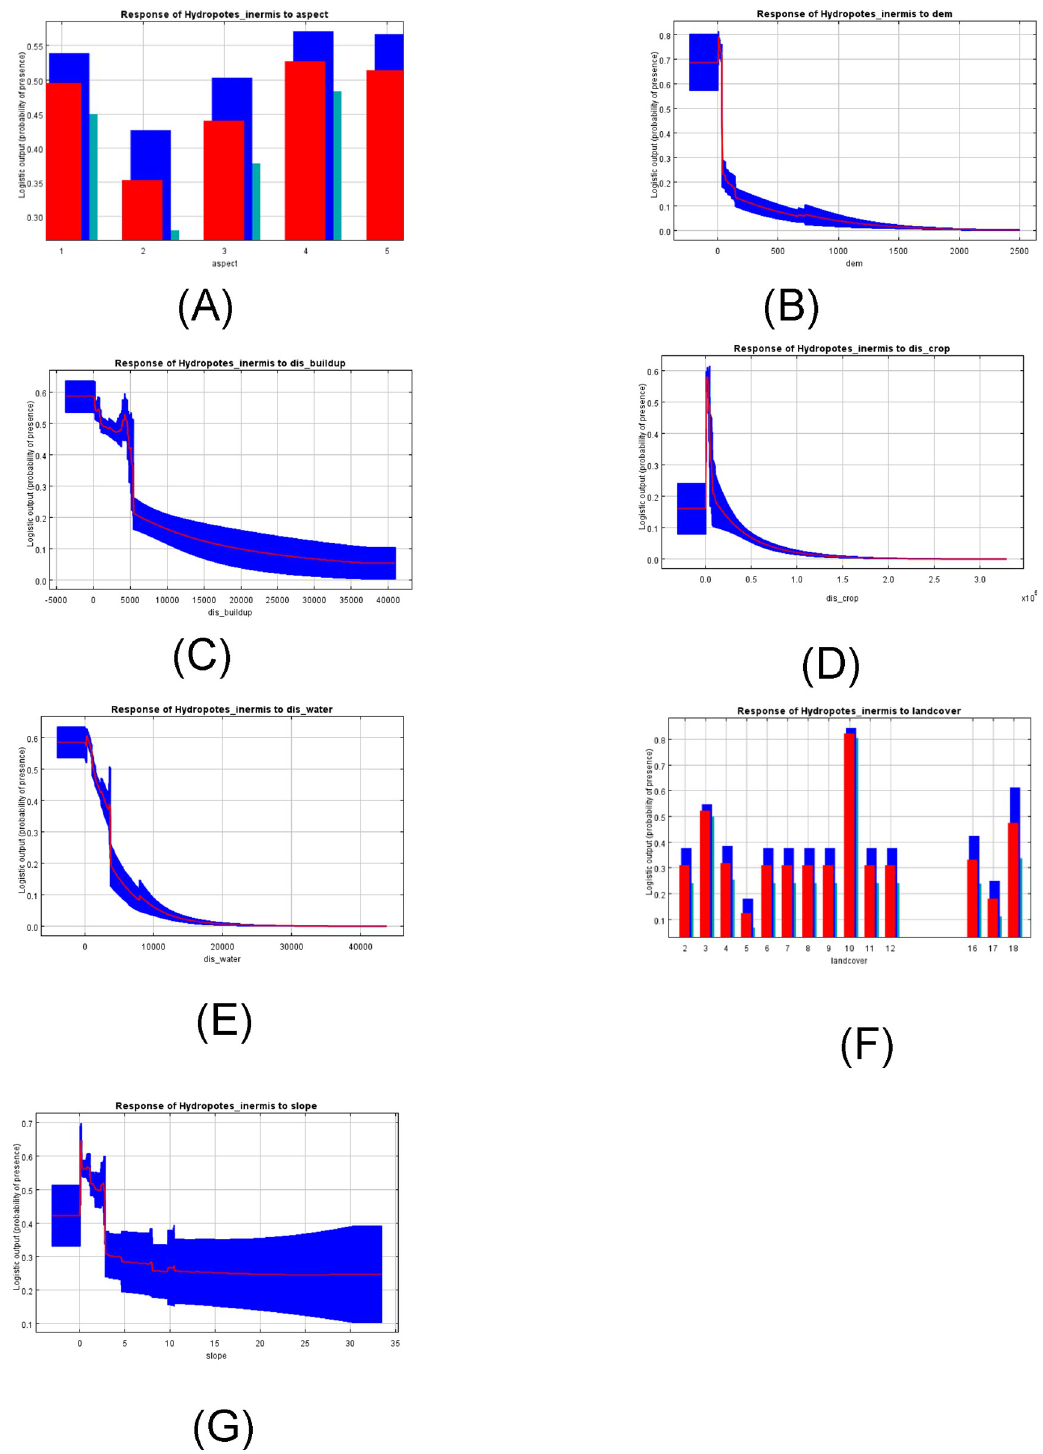
Fig 2. Response curves of water deer to environmental variables used for model prediction. (A: Aspect; B: DEM (Altitude); C: Distance to built-up; D: Distance to cropland; E: Distance to water; F: Land cover type; G:Slope).